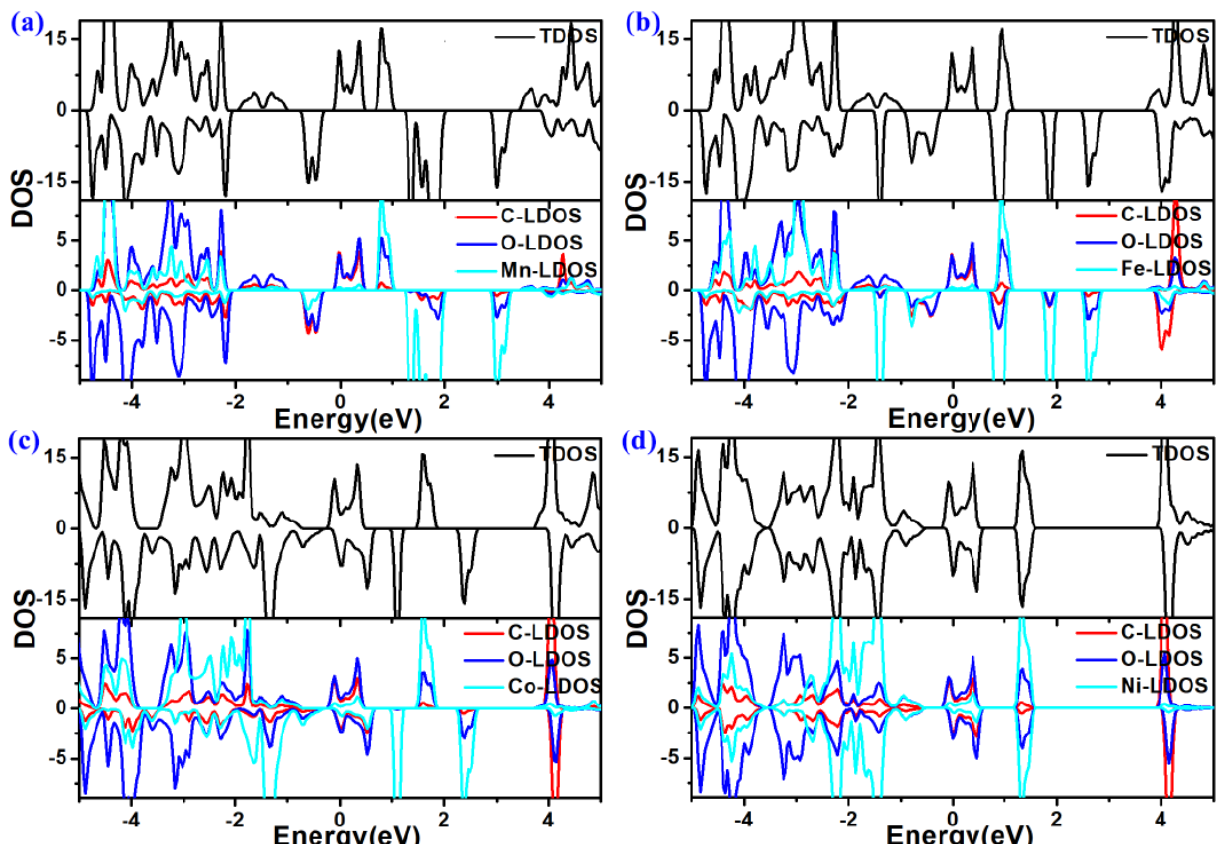
Figure 5. Total and local density of states (DOS) of ( a ) Mn-O-MOF, ( b ) Fe-O-MOF, ( c ) Co-O-MOF, and ( d ) Ni-O-MOF single-layer structures. The Fermi levels are set to 0 eV. Furthermore, it can be observed that the spin-up and spin-down DOSs are asymmetric, which results in spin magnetism. The calculated total magnetic moments ( M tot ) of the primitive hexagonal cells of Mn-O, Fe-O, Co-O, and Ni-O MOF single-layer structures are 9.00 µ B , 6.00 µ B , 3.73 µ B , and 0.50 µ B , respectively (Table 1). Compared with the